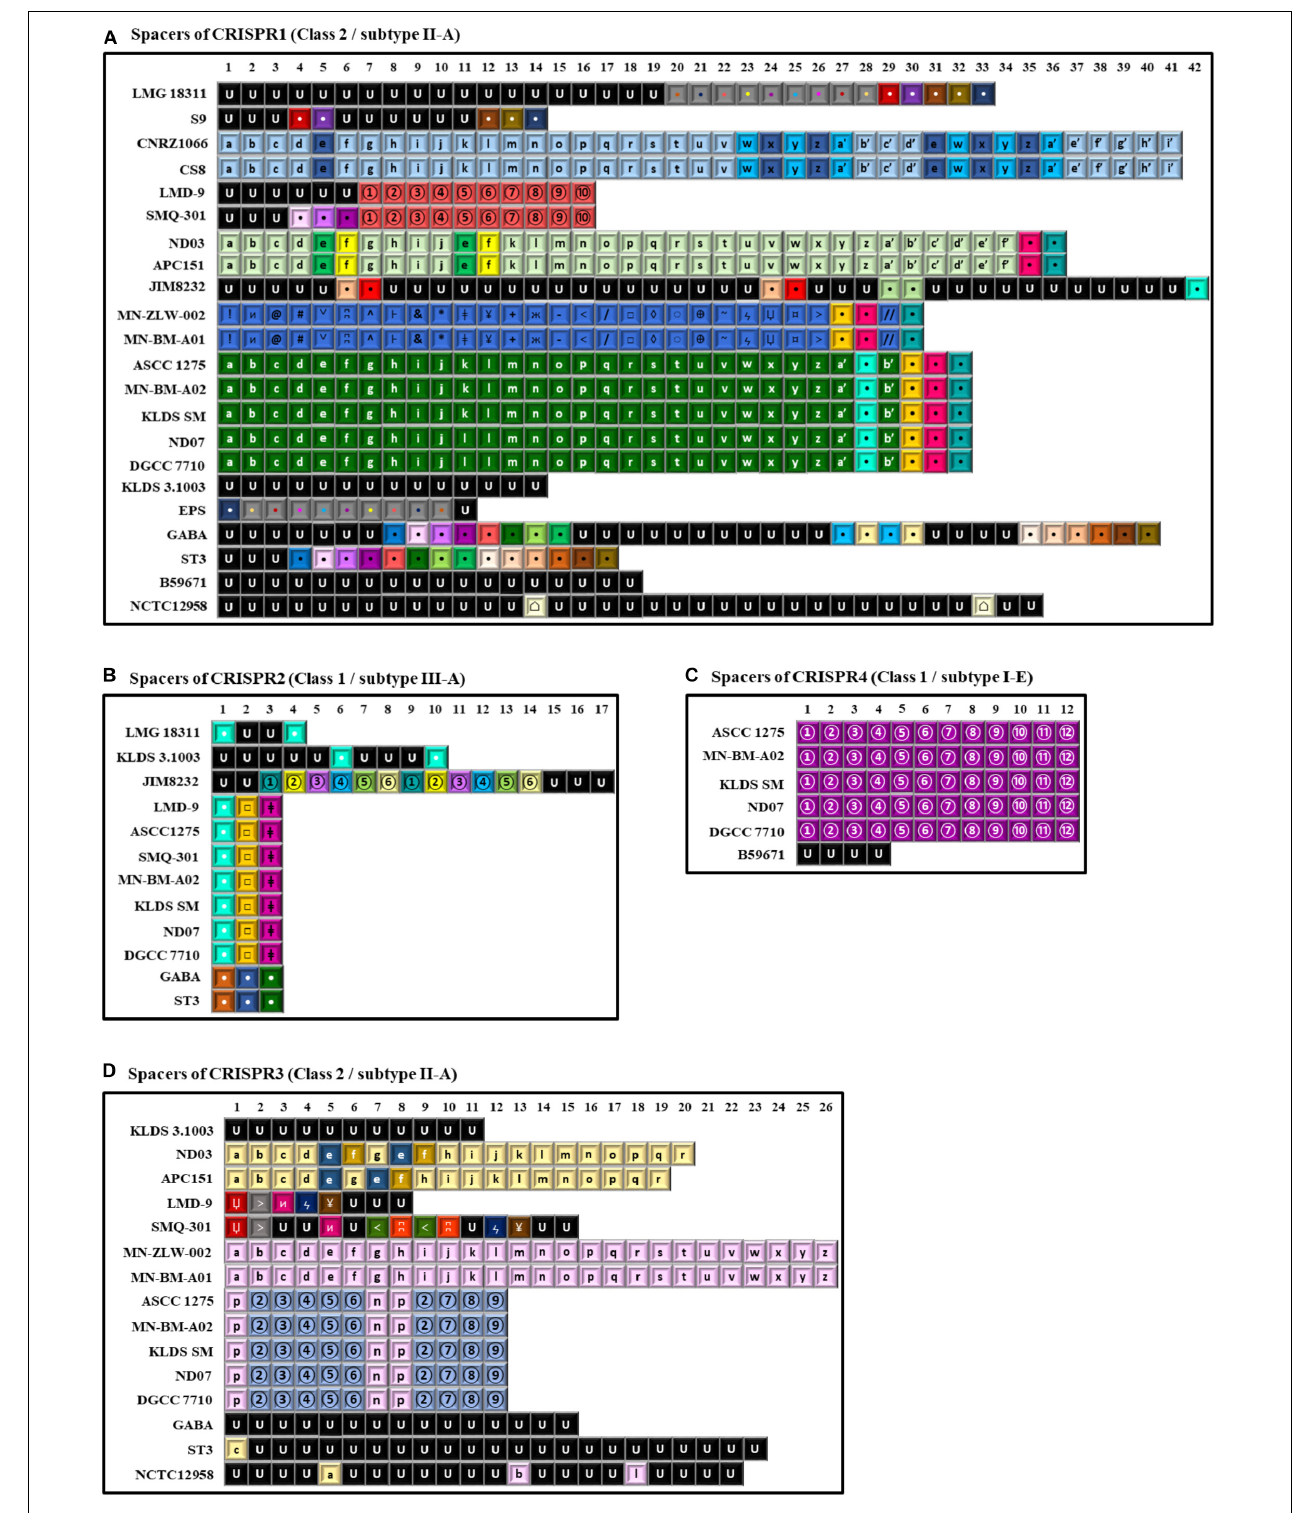
FIGURE 7 | Spacer sequences alignment of the various clustered regularly interspaced short palindromic repeats-CRISPR associated (CRISPR-Cas) system types found in the 22 S. thermophilus strains. In the alignments only the spacer sequences have been used. In each type of CRISPR-Cas system each spacer is represented by the combination of a character and a font color. The spacers represented in black font with the letter U correspond to unique spacers. Spacers represented by the same combination of a character and a font color correspond to identical spacers. Spacers of CRISPR1 (A) , CRISPR2 (B) , CRISPR4 (C) , and CRISPR3 (D)